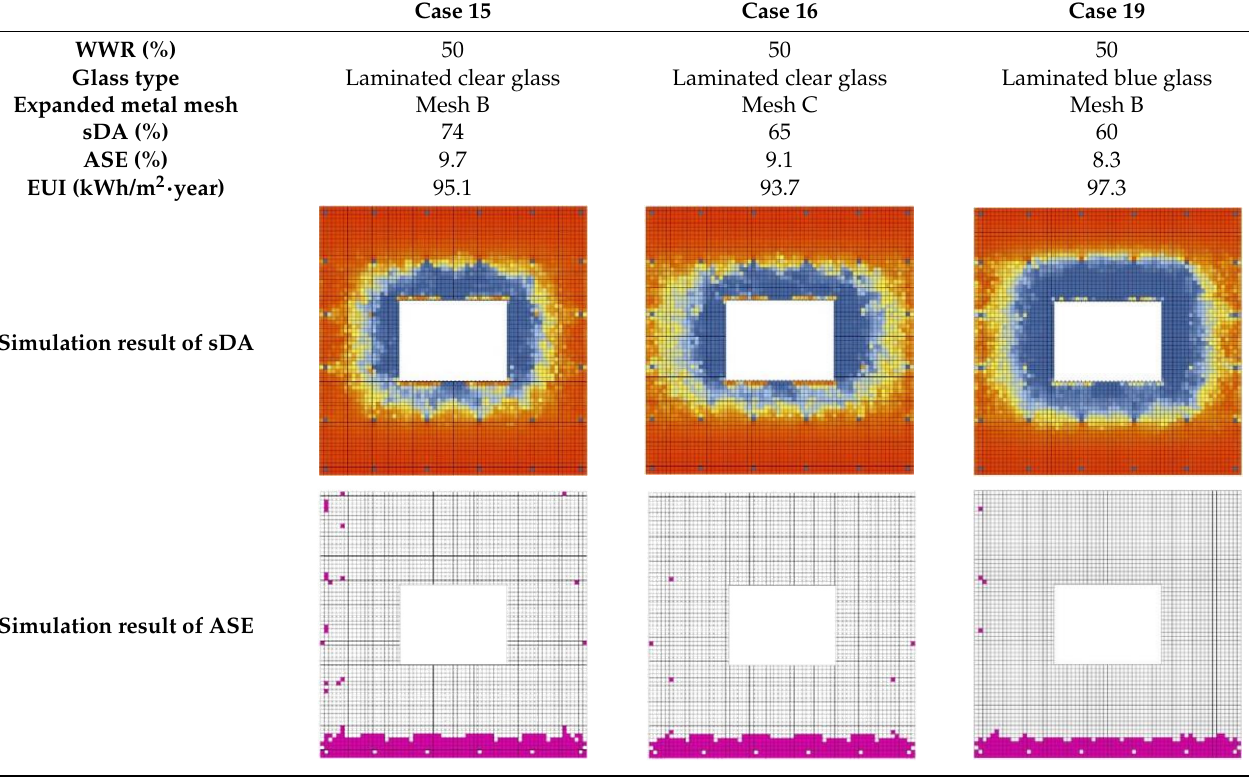
18 of 21 Figure 19. Energy simulation analysis of cases with WWR = 30%. When WWR = 80% (Figure 17), the EUI is lower when using glass with lower SHGC or expanded metal mesh with a smaller perforated ratio. When Low-E glass is used, since the glass blocks a large amount of solar radiation, the influence of different perforated